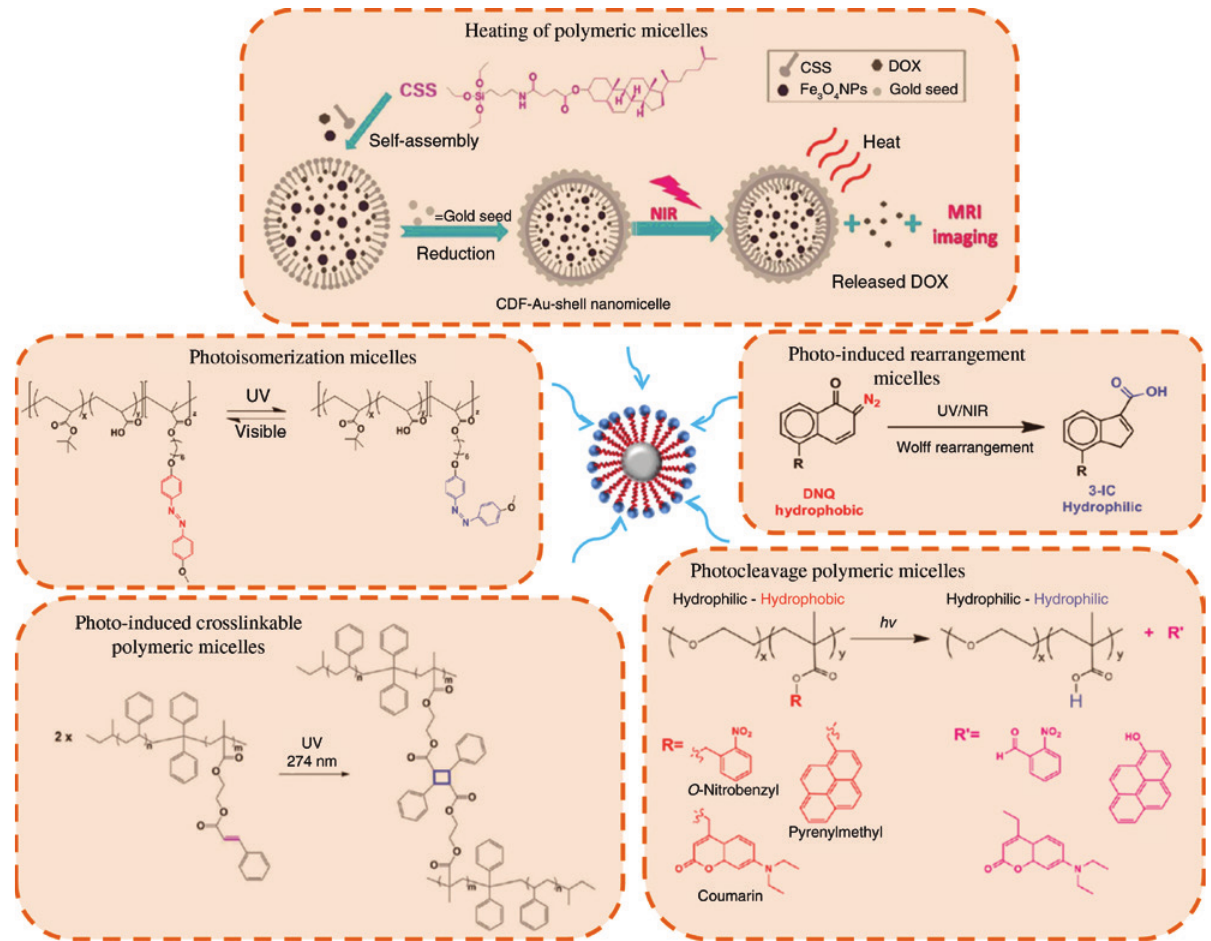
Figure 10: Schematic illustration of different release mechanisms of photo-responsive micelles. Reprinted with permission from [168]. Copyright 2014 Royal Society of